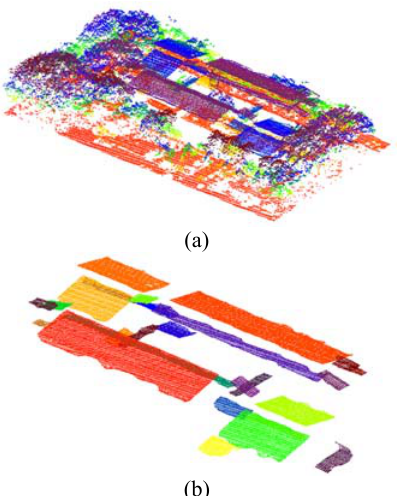
Figure 1. (a)LiDAR points and (b)the segmentation result .